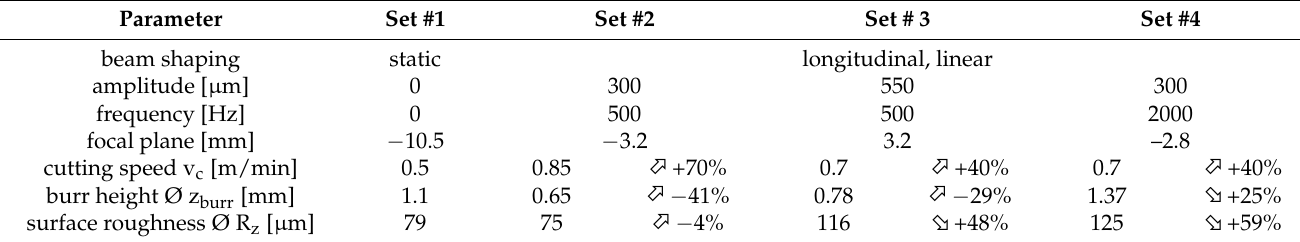
Figure 9. Cut edges of 12 mm stainless steel cut with the following parameters: ( a ) Set #1: Static beam shaping; and dif- ferent values of the longitudinal, linear beam oscillation parameters; ( b ) Set #2: 300 µm amplitude and 500 Hz frequency; ( c ) Set #3: 550 µm amplitude and 500 Hz frequency; ( d ) Set #4: 300 µm amplitude and 2000 Hz frequency. The results of set #1 (Figure 9a) correspond to the state-of-the-art LBFC with 3 kW laser power. This is the basis for the comparison with beam oscillation. Set #2 (Figure 9b) achieved the highest cutting speed with a 70% increase. Moreover, the burr has the greatest reduction by 41%. Set #2 is the only one to obtain a slightly reduced surface roughness by 4%. The results of set #2 are remarkable, as they cannot be achieved with static beam shaping with this laser power, even by adapting the focal plane. The ex- tended amplitude in set #3 (Figure 9c) still results in a 40% faster cutting speed and 29% less burr height, but the surface roughness increased by 48%. Raising the frequency in set #4 (Figure 9d) achieves a similar cutting speed as set #3. However, the burr height in- creased by 25% as well as the surface roughness rise by 59%.